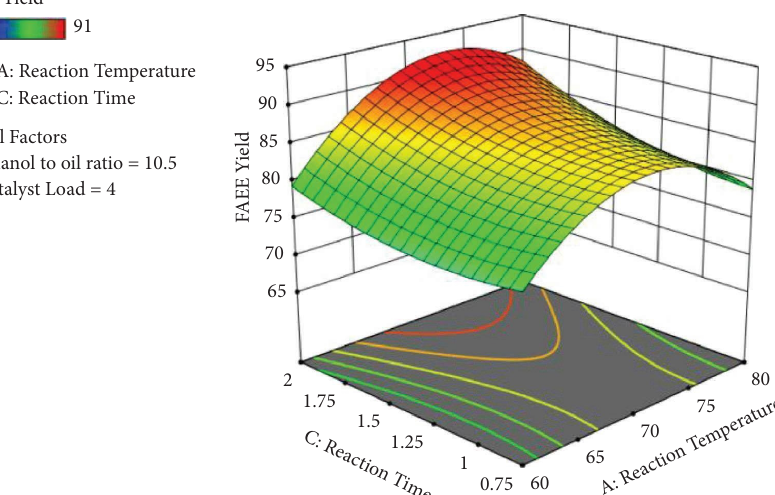
Figure 6: Te interaction efect of reaction temperature and reaction time versus percentage yield of FAEE (own